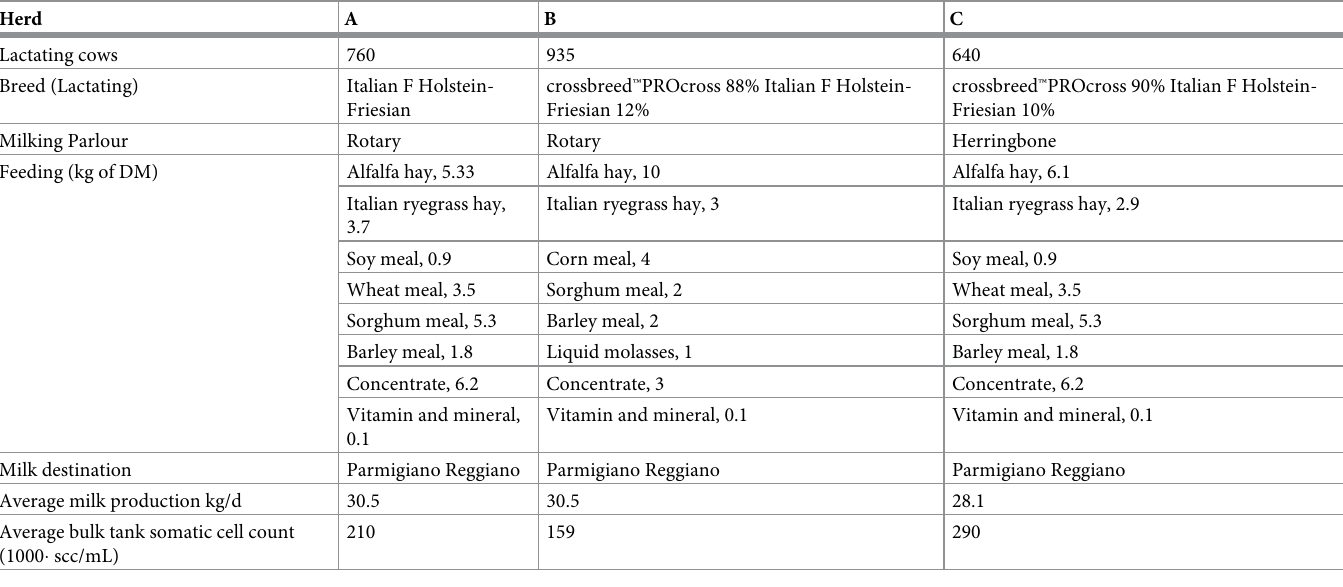
Table 1. Characteristics of herds considered in the current